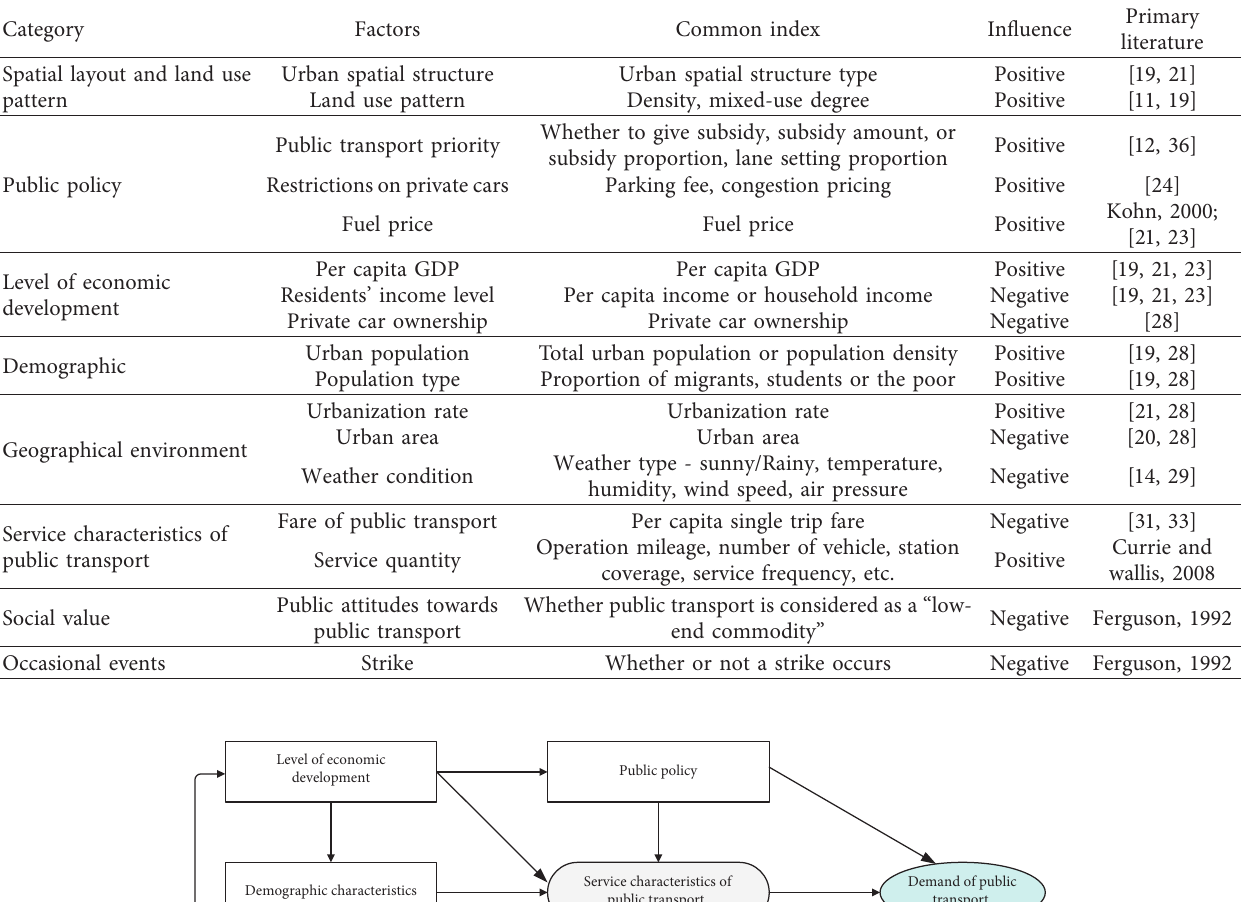
Table 1: Summary of the tested and significant factors affecting the demand for public transport.